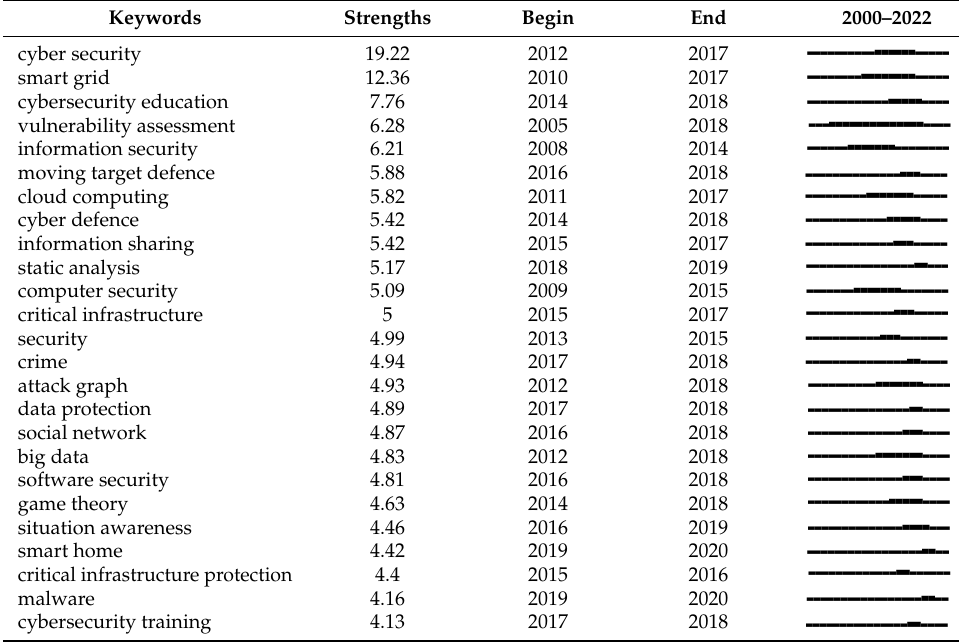
existing scientific contribution related to electronic commerce, cybersecurity, and digital resilience were illustrated), the authors exhibit a single big picture of the findings, con- necting the current state of knowledge. Thus, to illustrate the important outcomes of the study, a conceptual model of Resilience Right Decisions for Electronic Commerce and Cy- bersecurity was created (Figure 8). bersecurity was created (Figure 8).